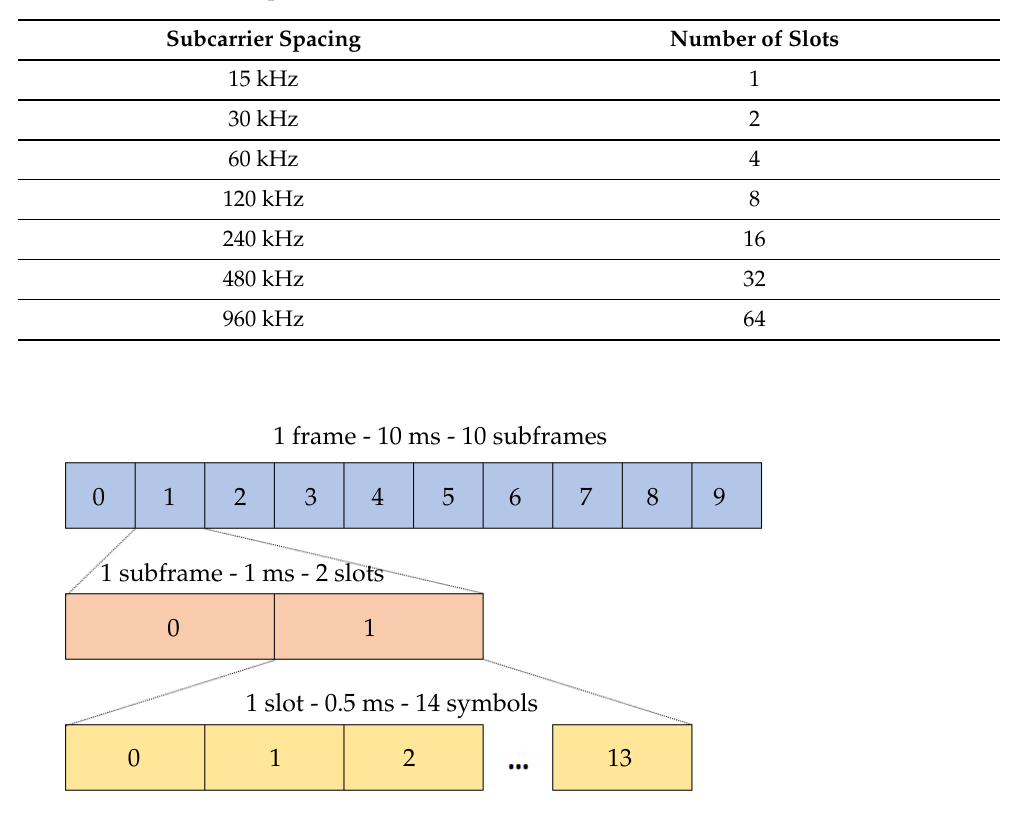
Figure 3. Frame structure for SCS 30